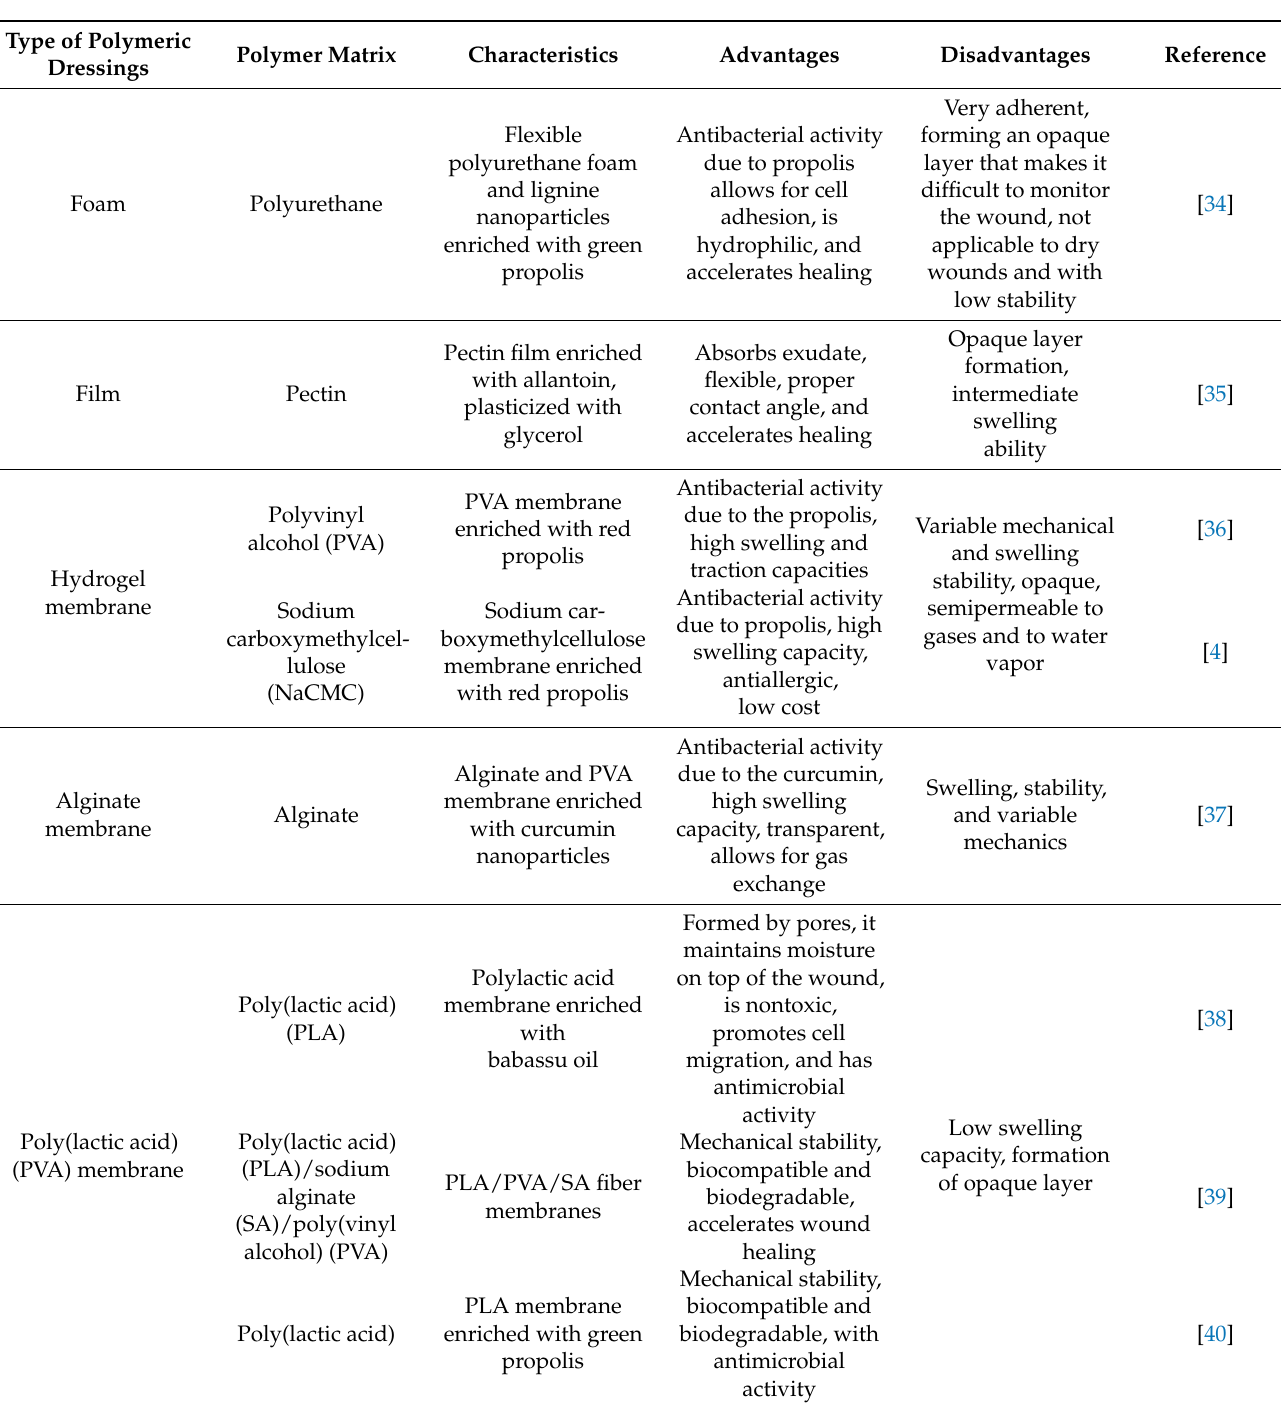
Table 7. Polymeric wound dressings: advantages and